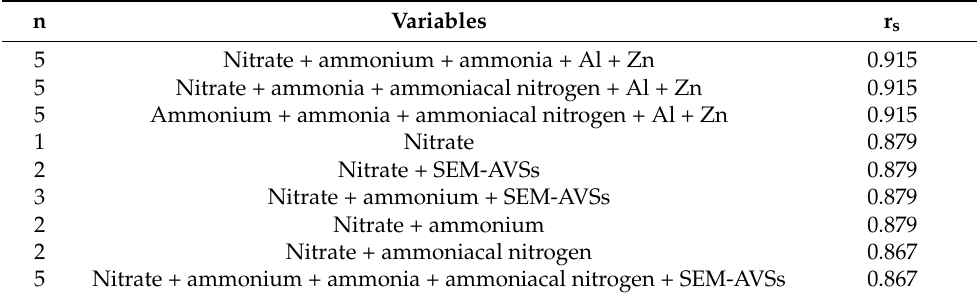
Table 3. BIOENV correlations (Spearman rank correlation coefficients, r s ) between benthic community structure and environmental variables ( n ).